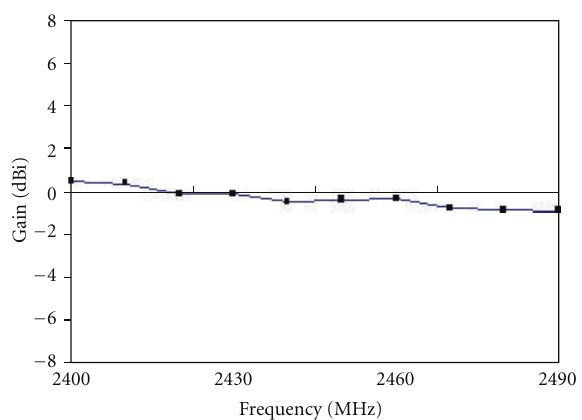
Figure 10: Measured gains of hybrid DR antenna for operating frequencies from 2.4 to 2.9 GHz.